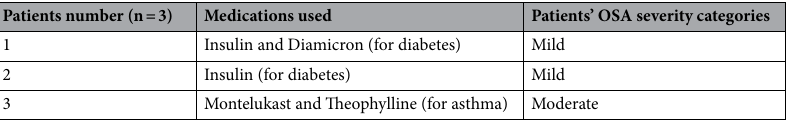
Table 7. Documented medications that were taken by the patients during the study period and patients’ OSA severity categories. OSA obstructive sleep